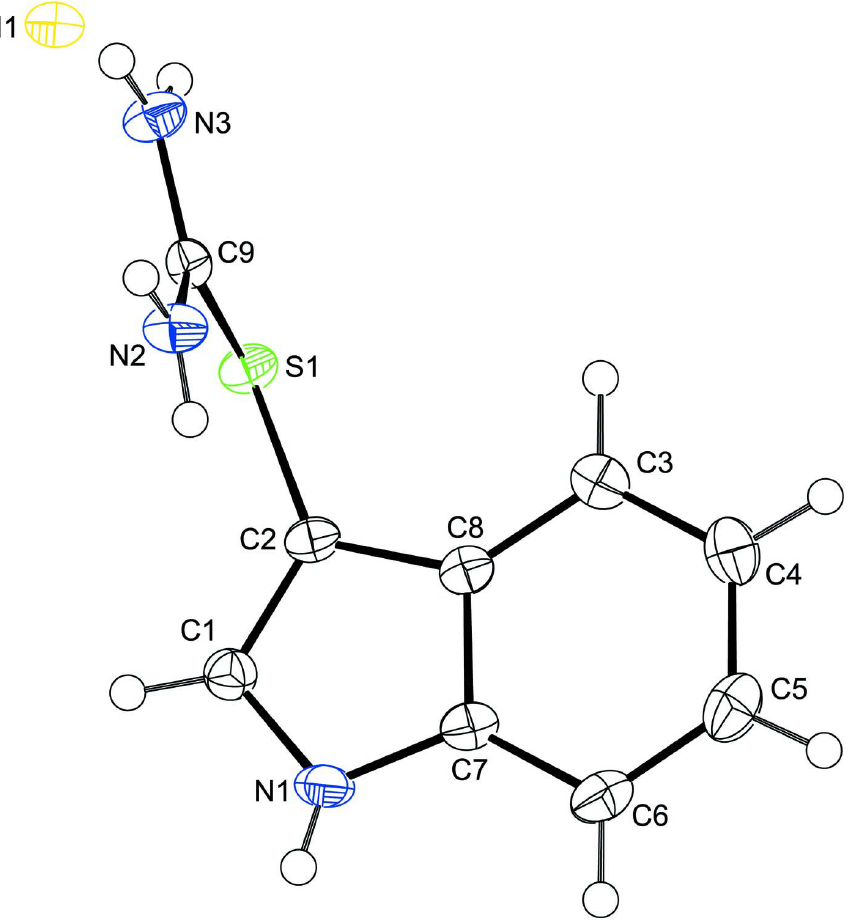
The molecular structure of (I). Displacement ellipsoids are drawn at the 50% probability level and H atoms are shown as small spheres of arbitrary